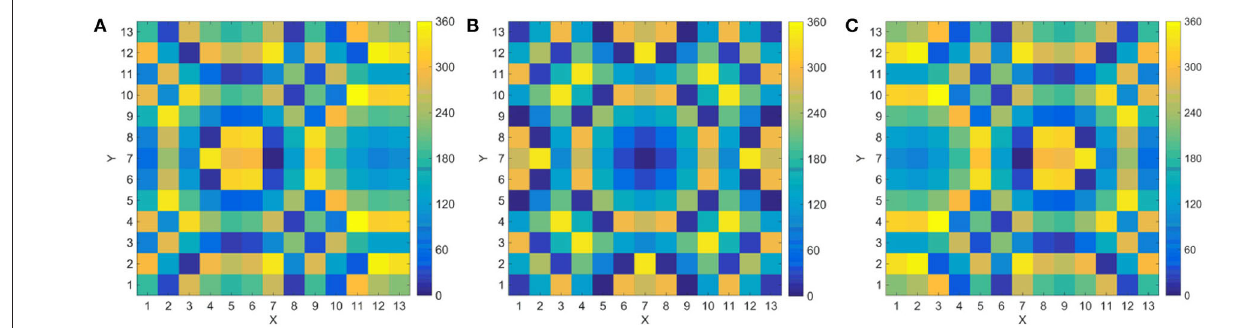
FIGURE 6 | Phase distributions for various scanning angles of